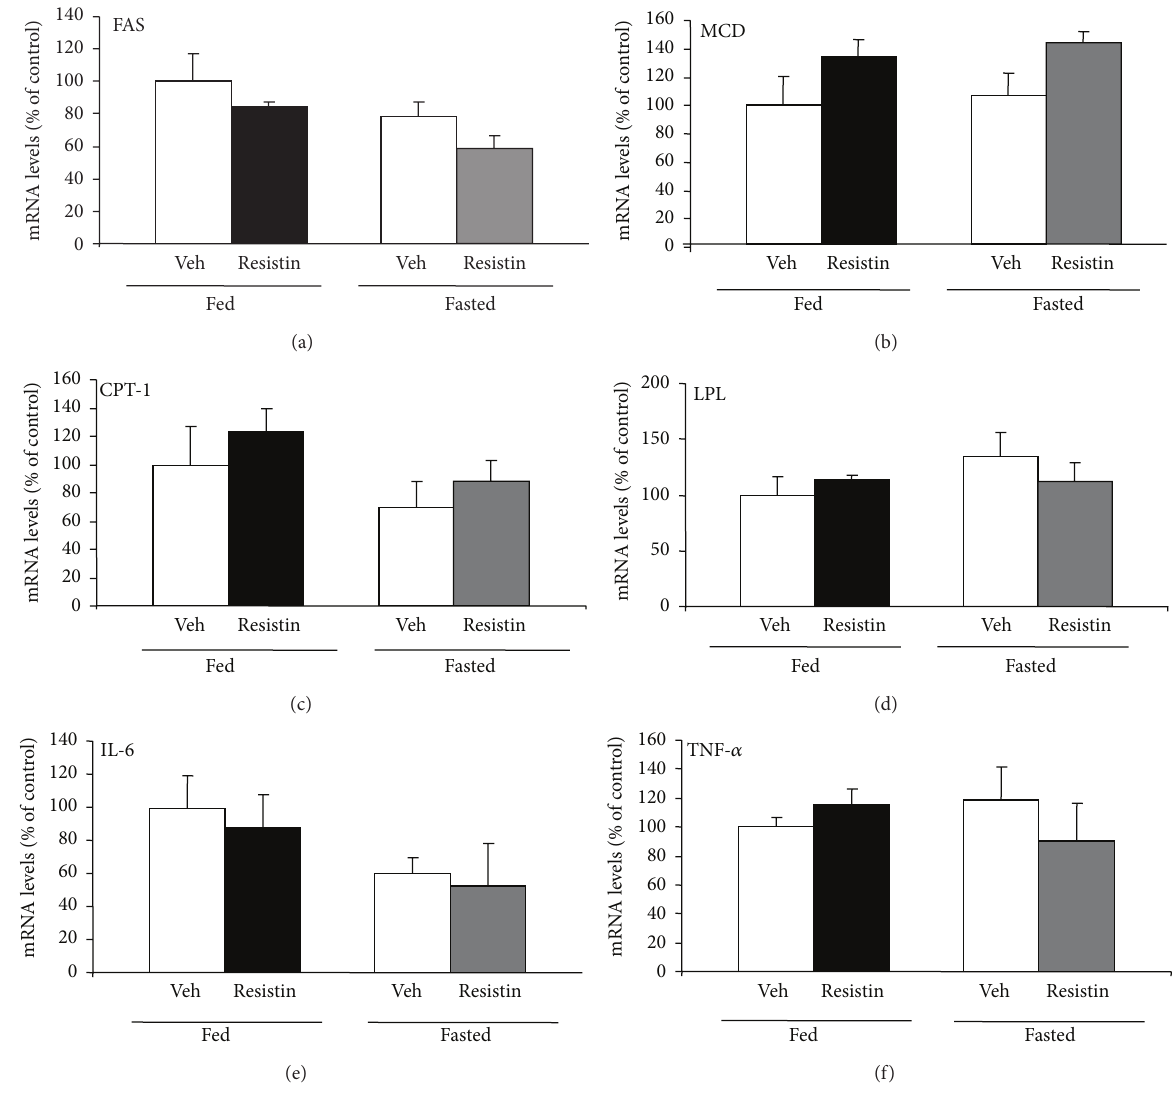
Figure 1: Effect of central acute administration of resistin on pituitary lipid metabolism enzymes and proinflammatory cytokines. Mean + SEM mRNA levels of FAS, MCD, CPT-1, LPL, IL-6, and TNF-alpha in the pituitary gland of fed and fasted rats following administration (I.C.V) of vehicle (Veh) or resistin (10ug/rat). Samples were obtained 90 min later. 𝑁 = 6 – 8 rats per group